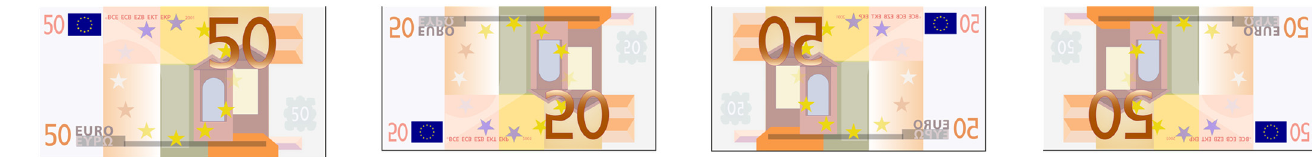
Figure 12. Disposition of a € 50 banknote in the different orientations analyzed.